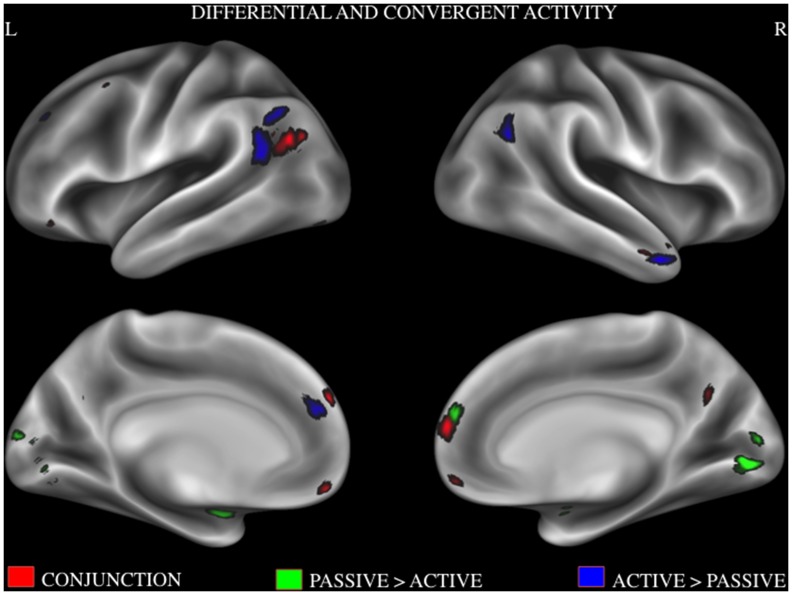
Combined activation likelihood estimation map showing significant activation clusters.red = active >passive; green = conjunction of active and passive; blue = passive>active. Surface maps of the activation likelihood clusters (false discovery rate P<.05) are shown on an inflated surface map in Caret [60].